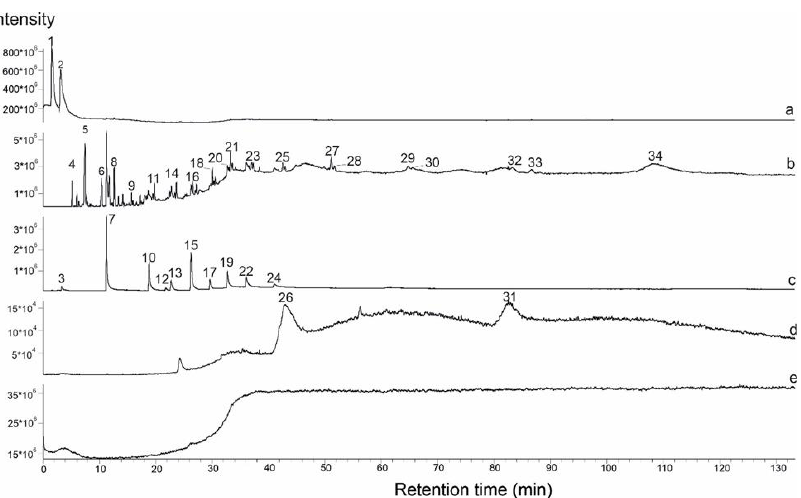
Figure 10. Results of GC – MS analysis of volatiles extracted via mechanical shock crushing from quartz D – 1 – 2 of the Dobroe deposit. Total ion chromatogram (TIC) (a) and reconstructed ion chromatograms (RIC) for m / z (43 + 57 + 71 + 85) (b), m / z 60 (c), m / z 149 (d), and blank (TIC) (e). 1—Nitrogen (N 2